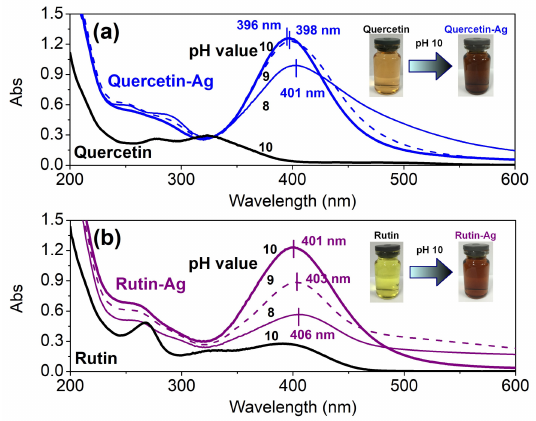
Figure 2. UV–Vis absorption spectra of the AgNPs synthesized by quercetin ( a ) and rutin ( b ) at various